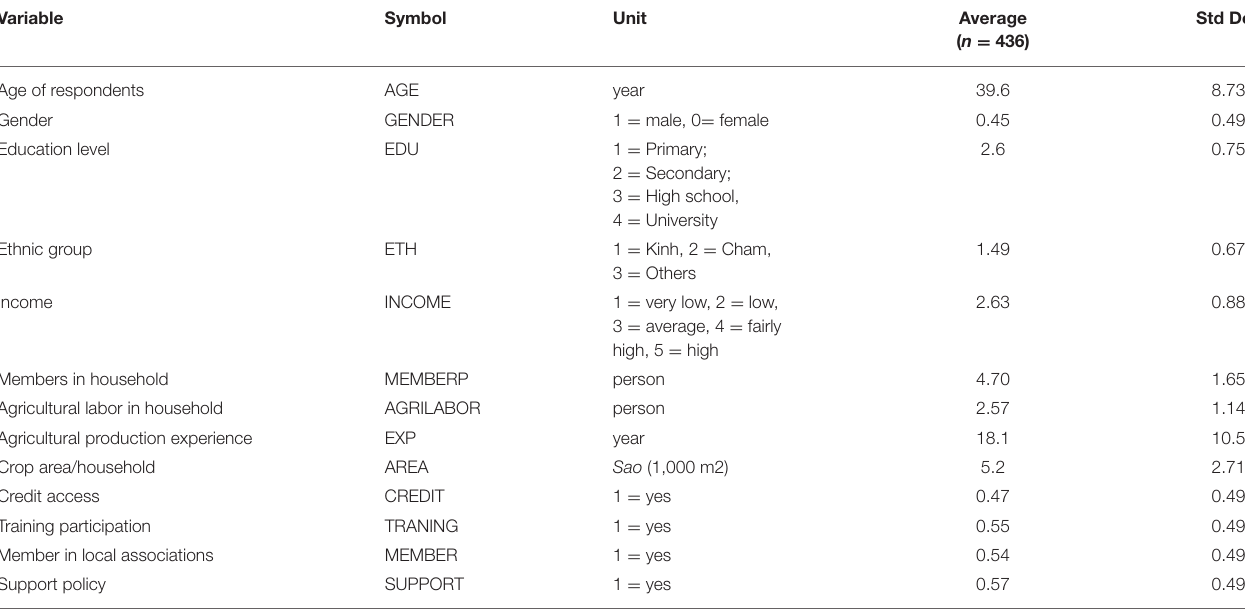
TABLE 8 | The explanatory variables in the binary logit model. Variable